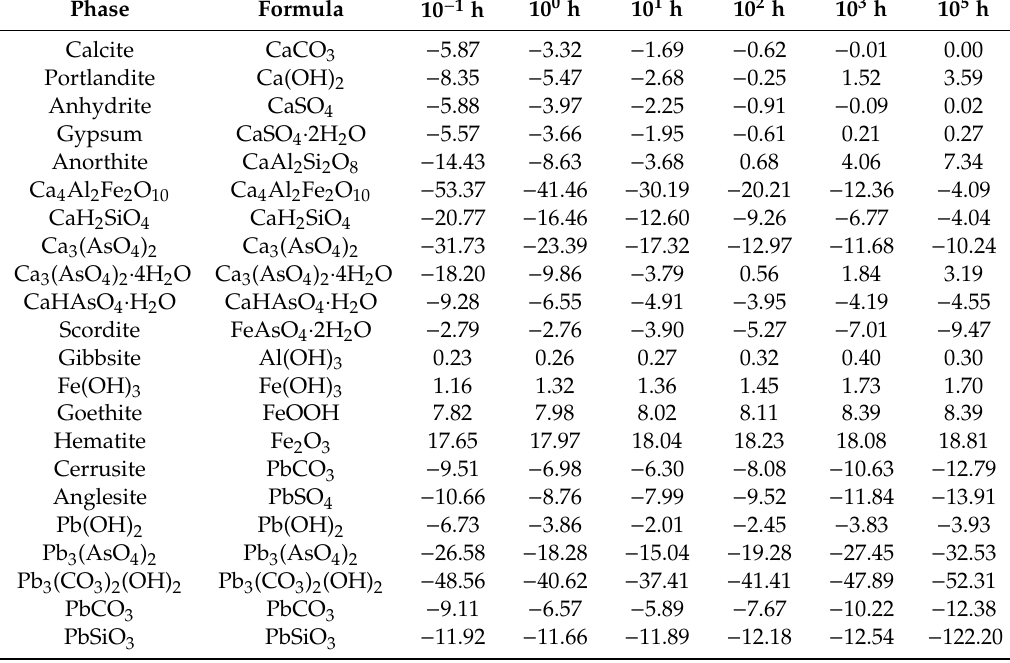
Table 10. SI’s of selected compounds at di ff erent stages of leaching time (modeling results).